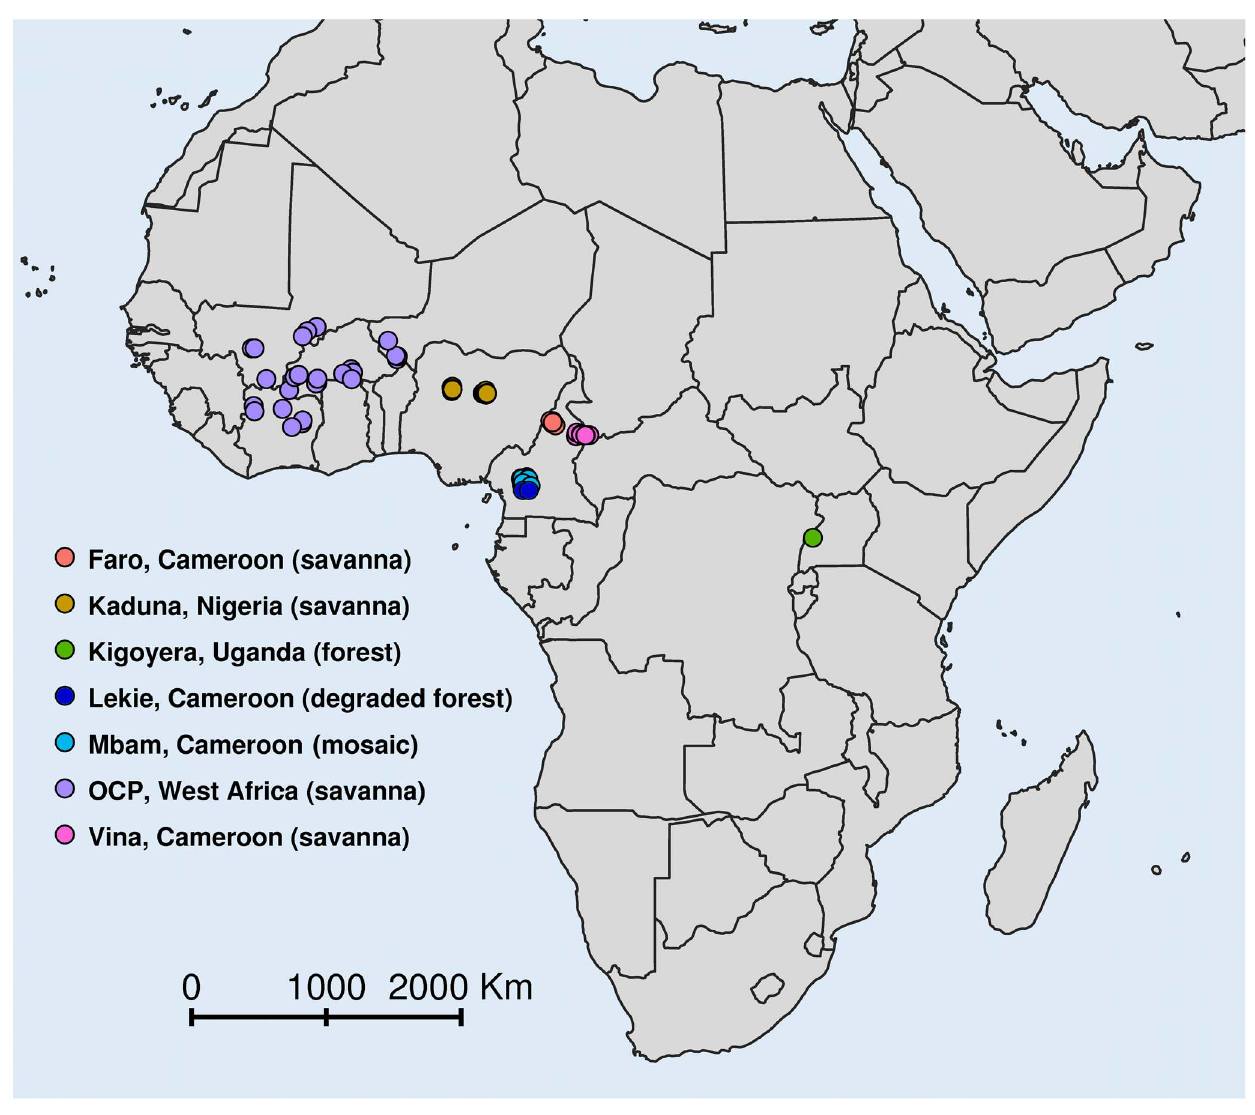
Figure 1. Locations of study sites.